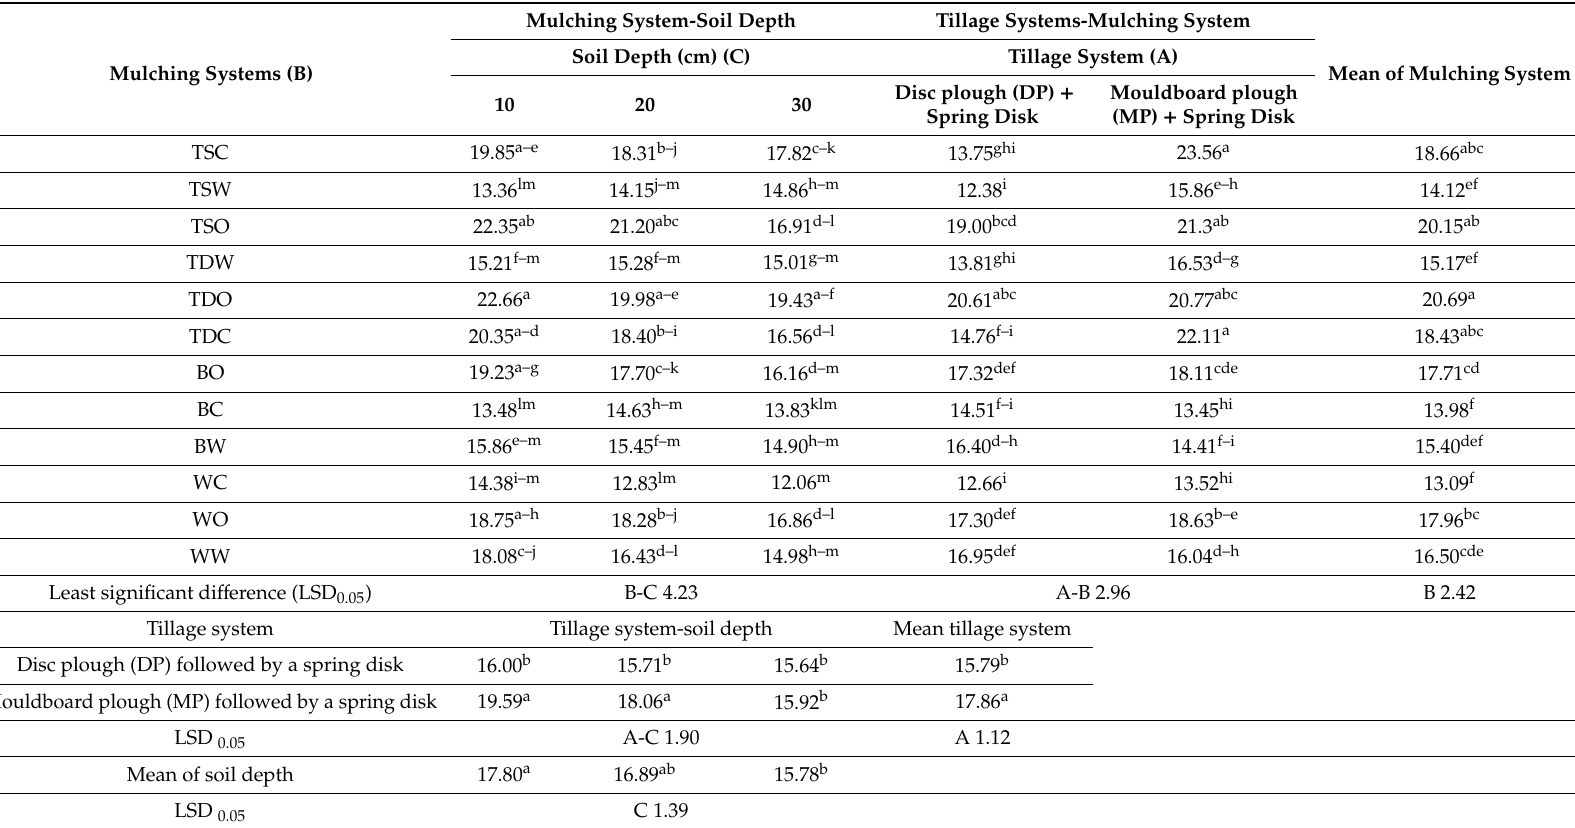
Table 6. Mean of the thermal e ffi ciency ( η th ) of the DES at various soil depths for the di ff erent soil